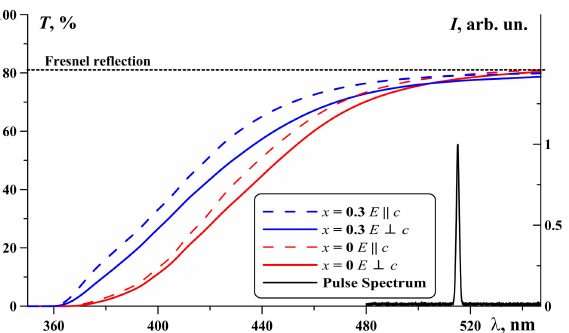
Figure 1. Transmittance spectra of CSVO crystals for x = 0 (red line) and x = 0.3 (blue line) for perpendicular (solid line) and parallel (dashed line) orientation of the light polarization and crystal c-axis. The solid black peak at 515 nm is the laser pulse